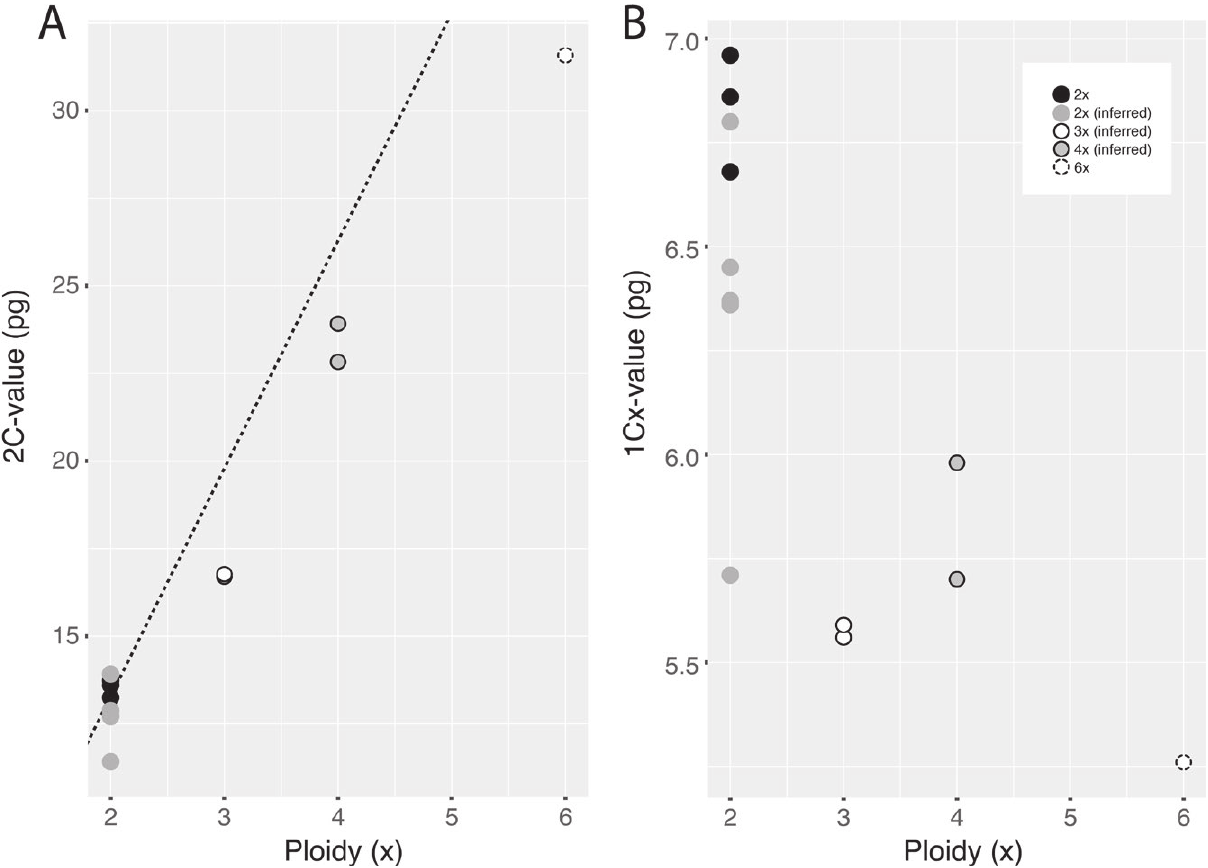
Figure 2. A. Scatter plot of observed 2C-values in Marshallia grouped by ploidy level. The dotted line represents the projection of expected 2C-values given a proportional increase of GS with ascending ploidy levels (note that the prediction is based on average 2C-values of dip- loid taxa). B. Scatter plot of observed 1Cx-values in Marshallia grouped by ploidy level, which illustrate the reduction of the monoploid genome in ascending ploidy